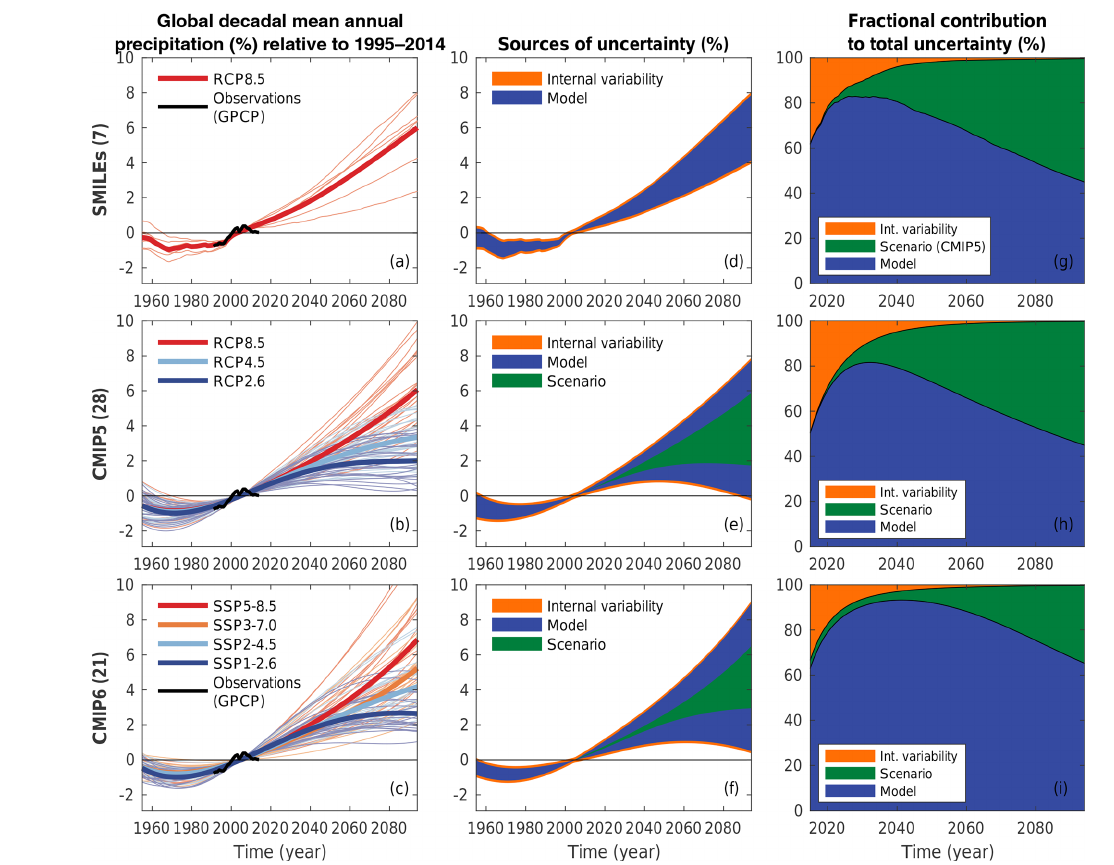
Figure 2. As Fig. 1 but for precipitation (observations from Adler et al.,